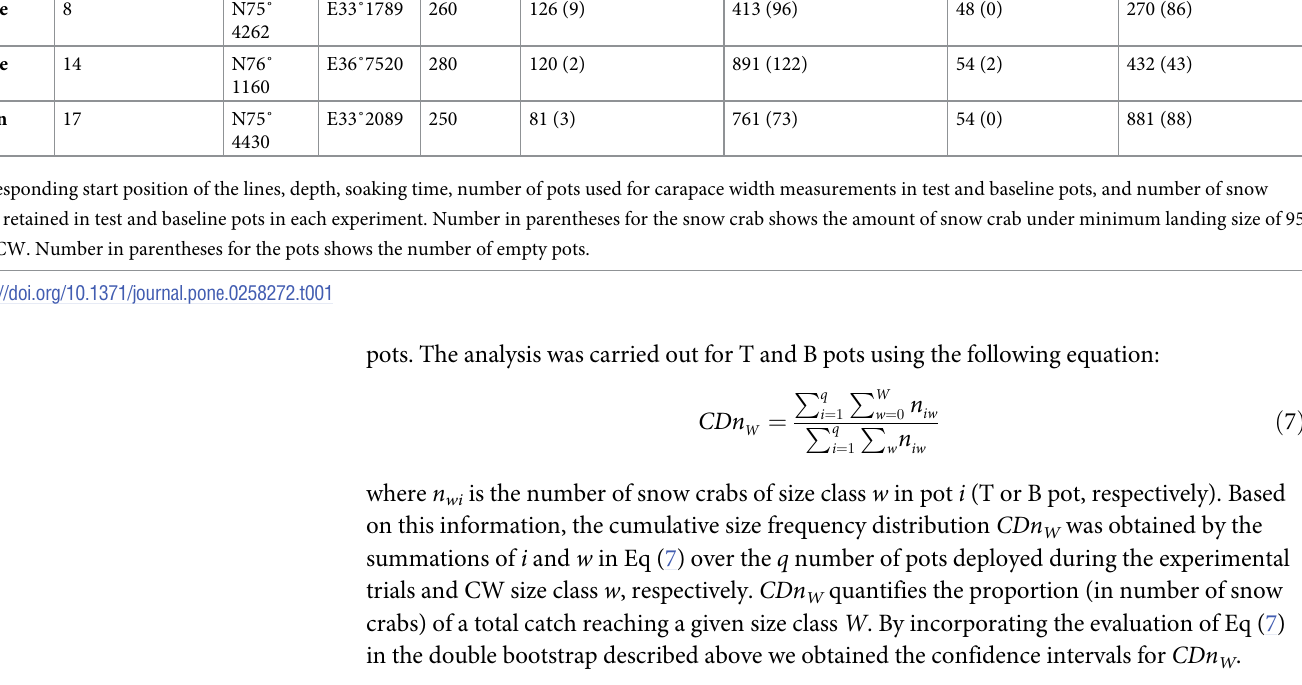
Table 1. Experimental data sets of the three experiments.